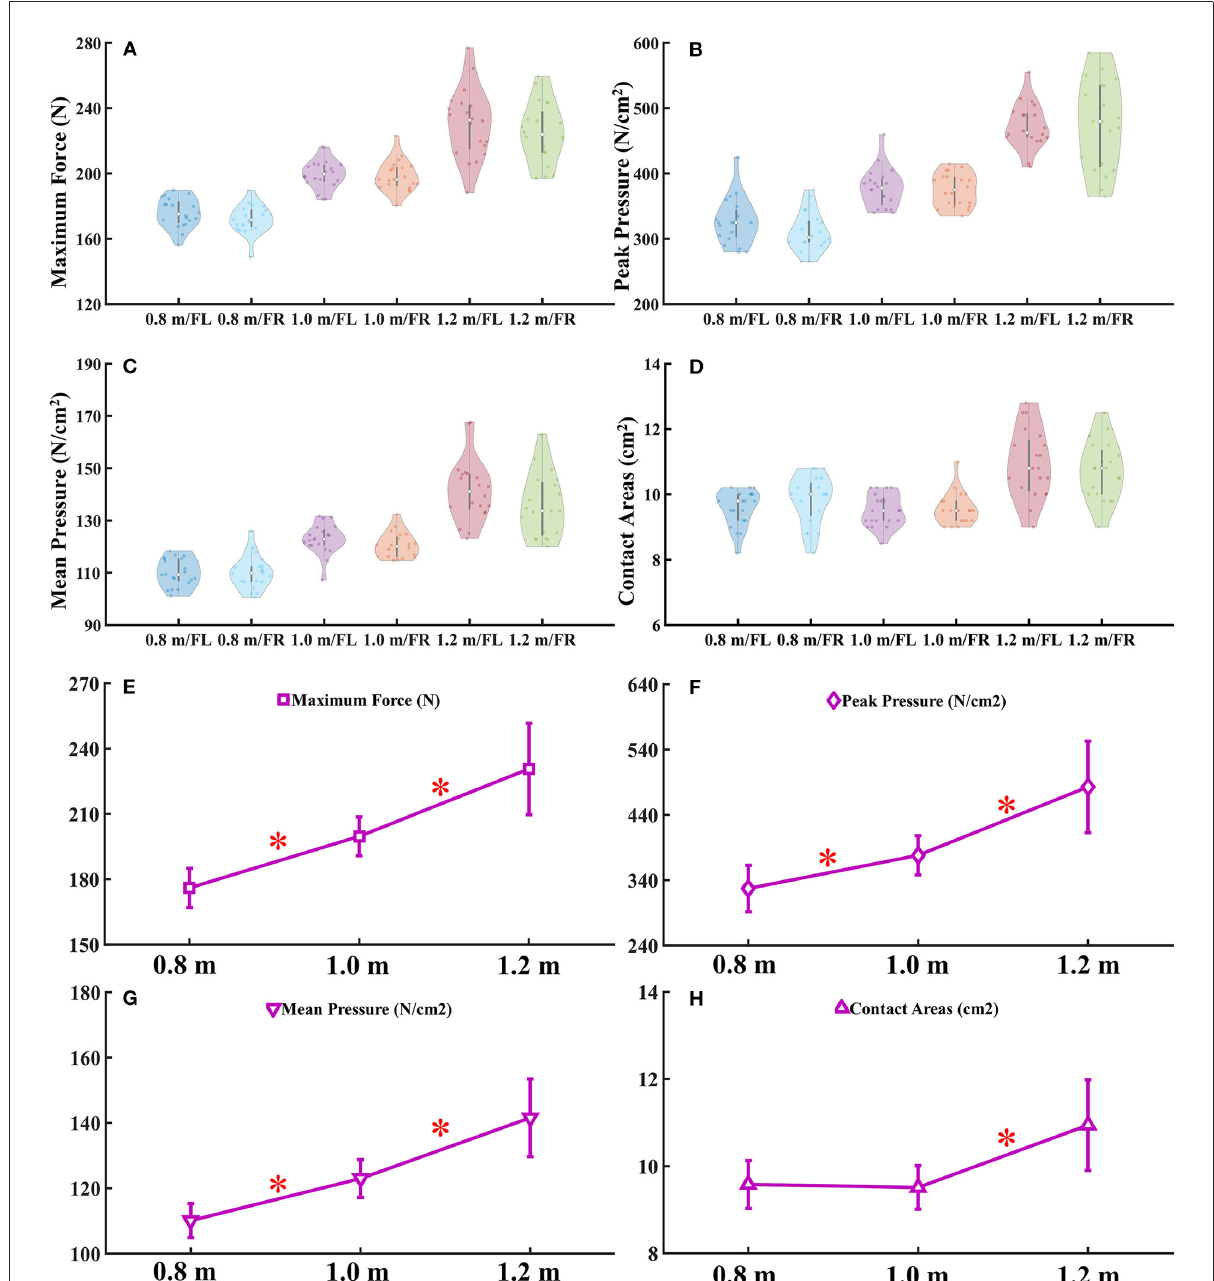
FIGURE2 (A–D) The violin plot of E-Med data distribution. (E–H) Comparison of forelimb paw right in maximum force, peak and mean pressure and contact areas during landing from different heights. FL, Forelimb paw left; FR, Forelimb paw right; “*” represents significant difference between heights. 1 MPa = 1,000 N/cm 2